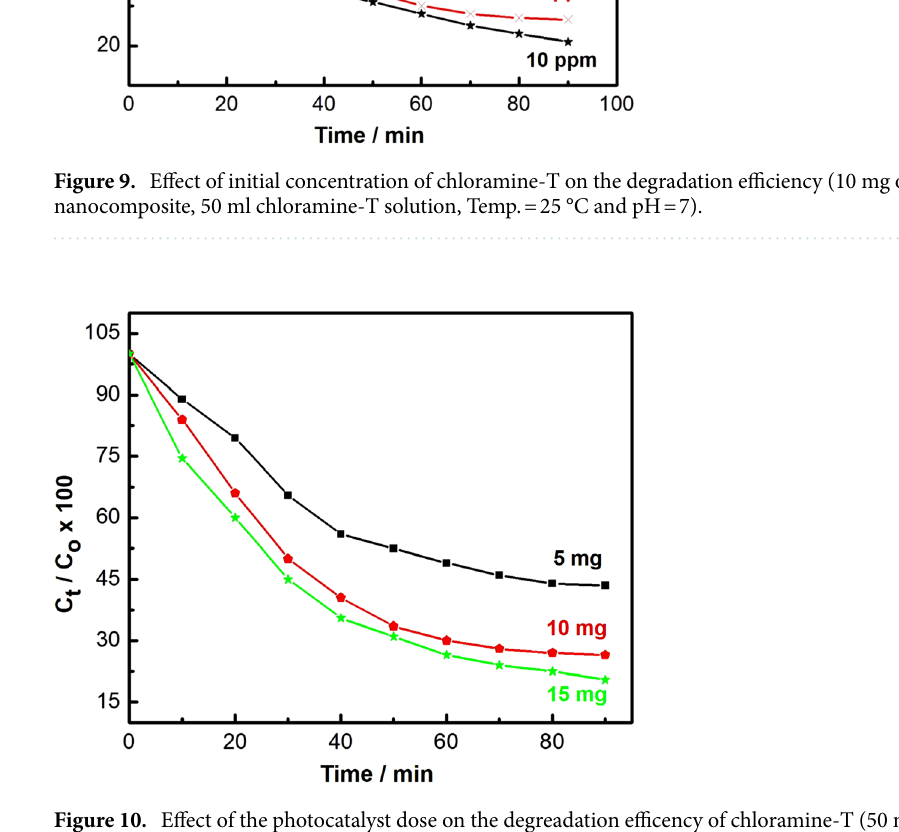
Figure 10. Effect of the photocatalyst dose on the degreadation efficency of chloramine-T (50 ml chloramine-T solution (20 mg/l), Temp. = 25 °C and pH